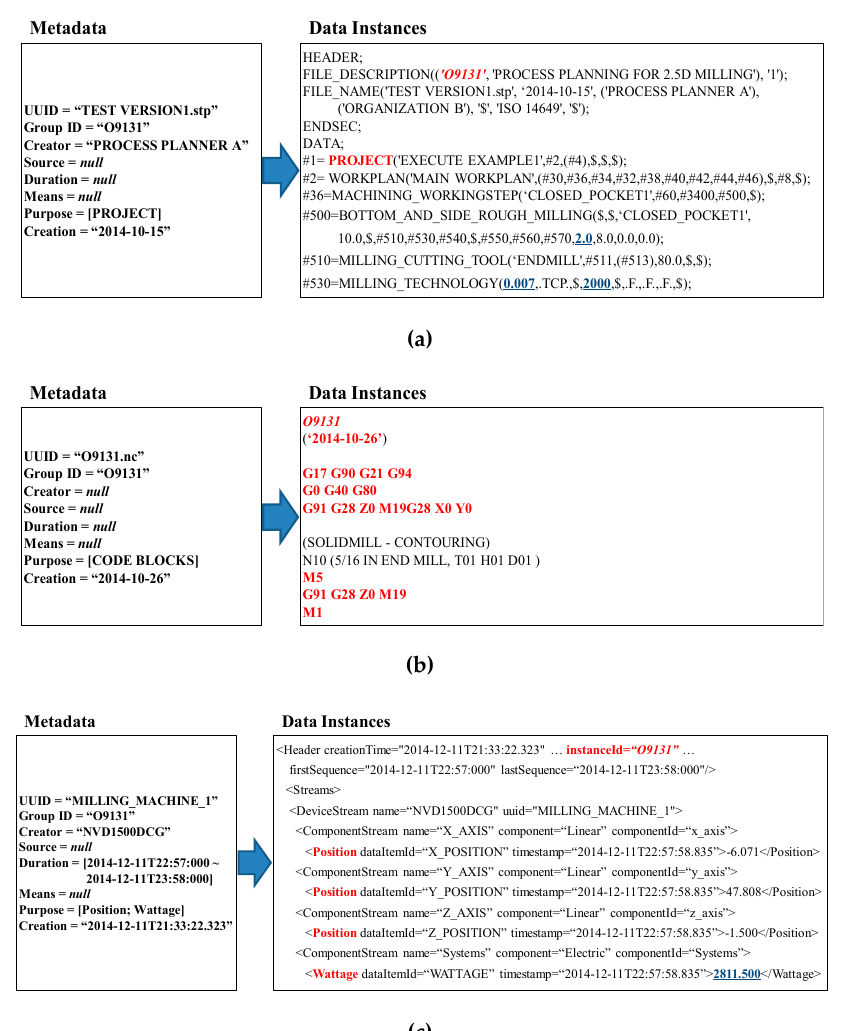
Figure 5. Data retrieval using a metadata-based search ( a ) ISO14649 program; ( b ) Numerical Control